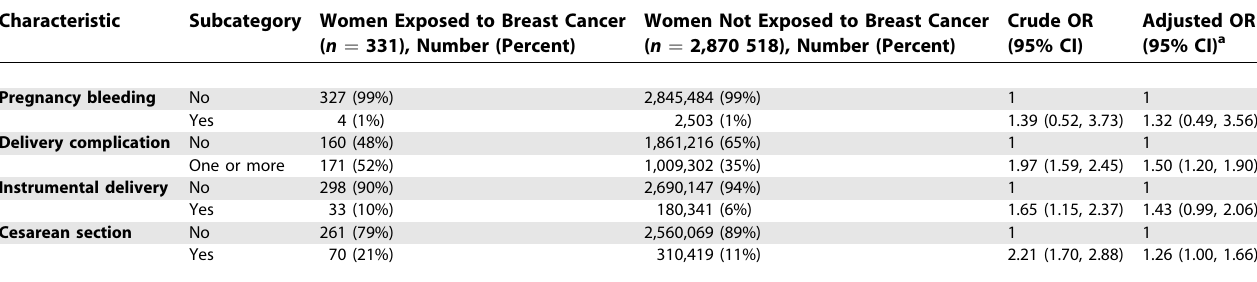
Table 2. Crude and Adjusted ORs for Birth Outcome in Women Previously Treated for Breast Cancer Compared with the General Population